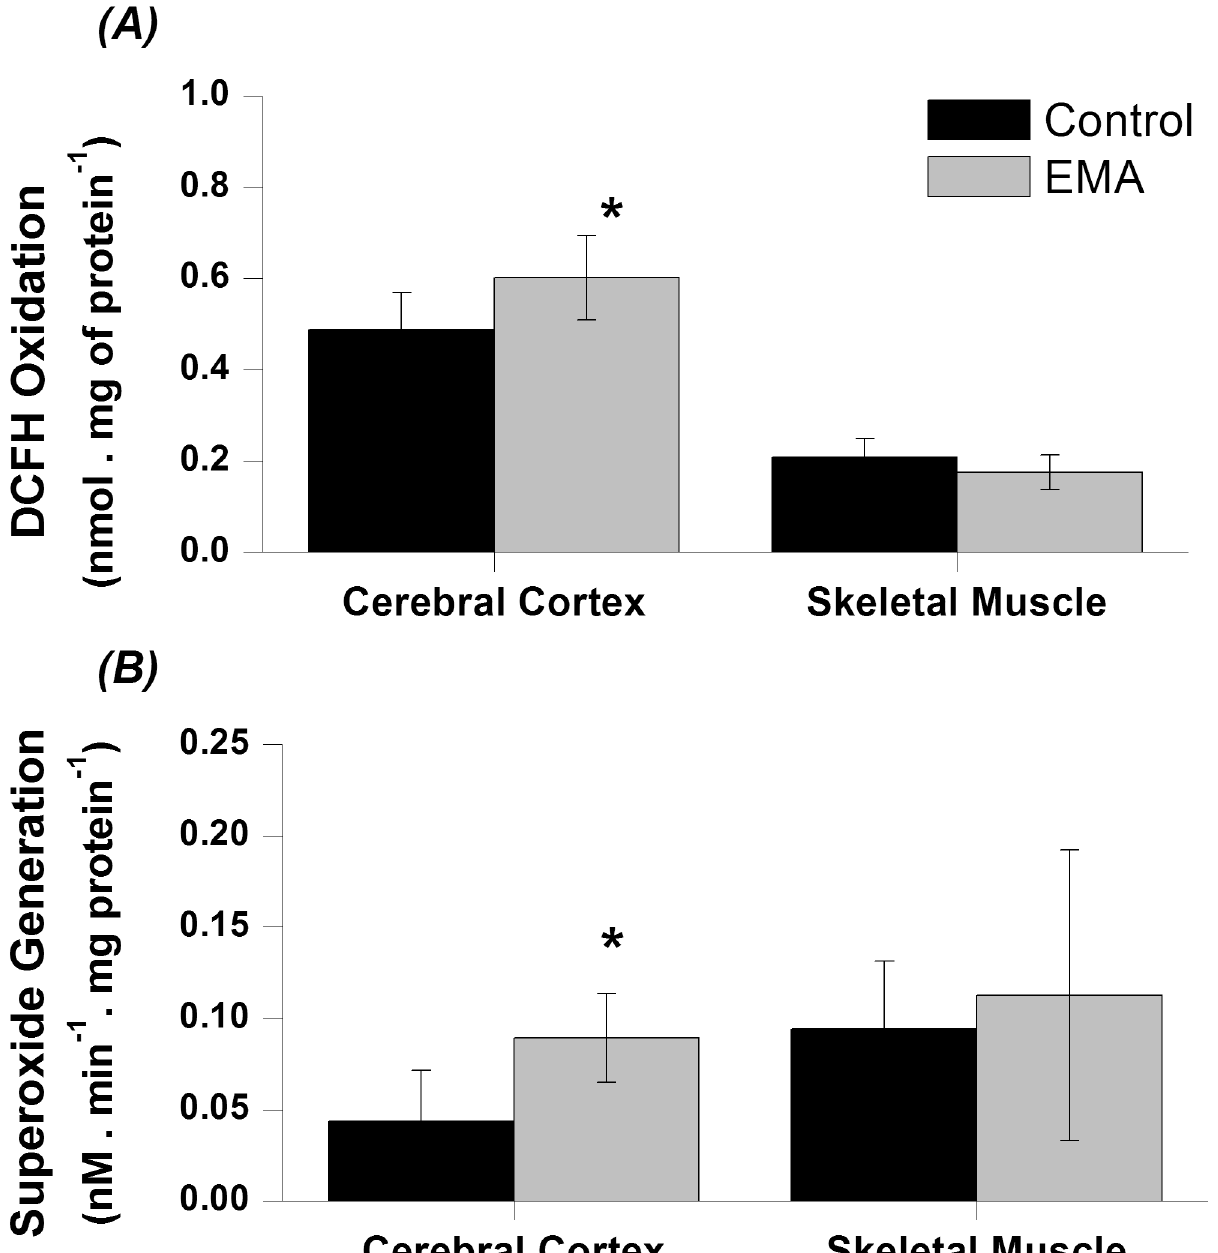
Fig 3. Effect of acute ethylmalonic acid (EMA) administration (6 μ mol/g) on DCFH oxidation (A) and superoxide generation (B) in cerebral cortex and skeletal muscle from 30-day-old rats. The experiments were performed in duplicate and the data represent mean ± standard error of the mean and are expressed as DCFH oxidation: nmol. mg protein -1 ; superoxide: nM. min -1 . mg of protein -1 (n = 5 – 8 per group). * p < 0.05 compared to control group (Student t test for independent